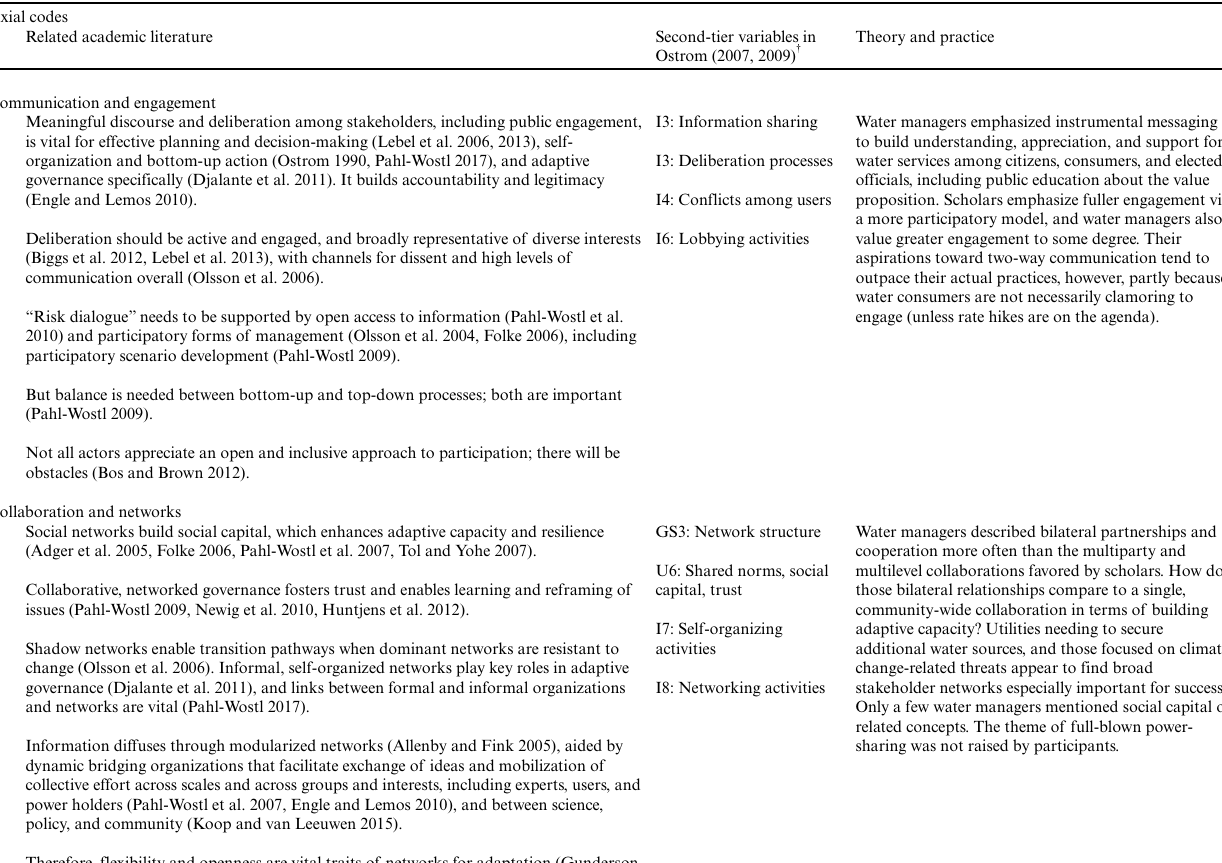
Table 2 . Themes common to both study participants’ comments and the research literature Axial codes Related academic literature Second-tier variables in